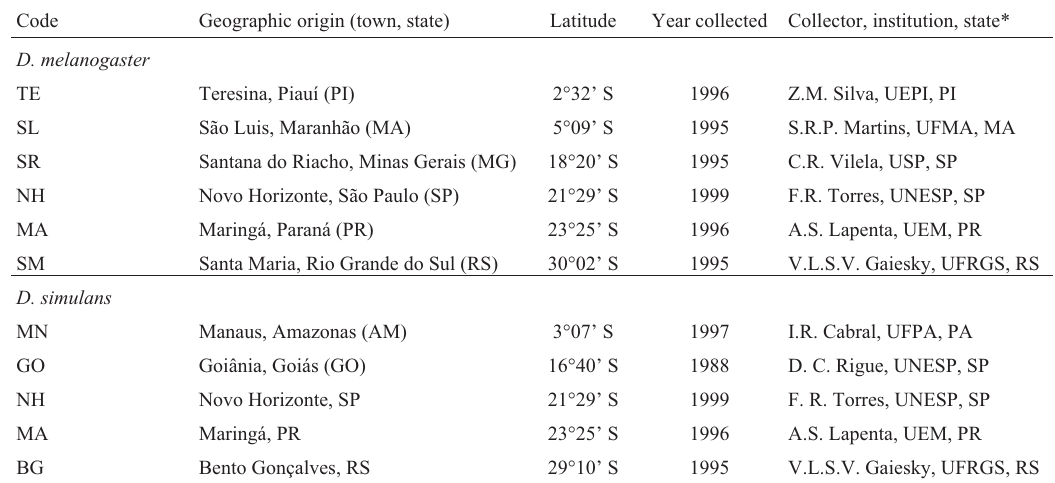
Table 1 - Brazilian Drosophila strains used in this study, geographic origin, latitude and year of collection.